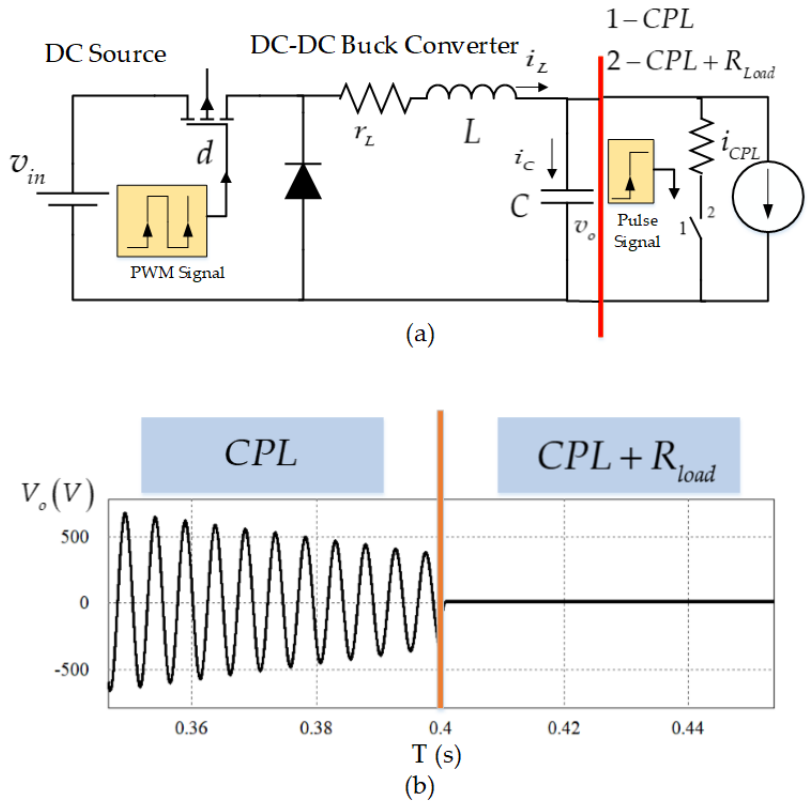
Figure 6. The influence of passive loads on the output voltage oscillations generated by the CPL. ( a ) A buck converter feeding two types of loads, ( − 1): CPL alone. ( − 2): CPL + R, ( b ) simulation result.